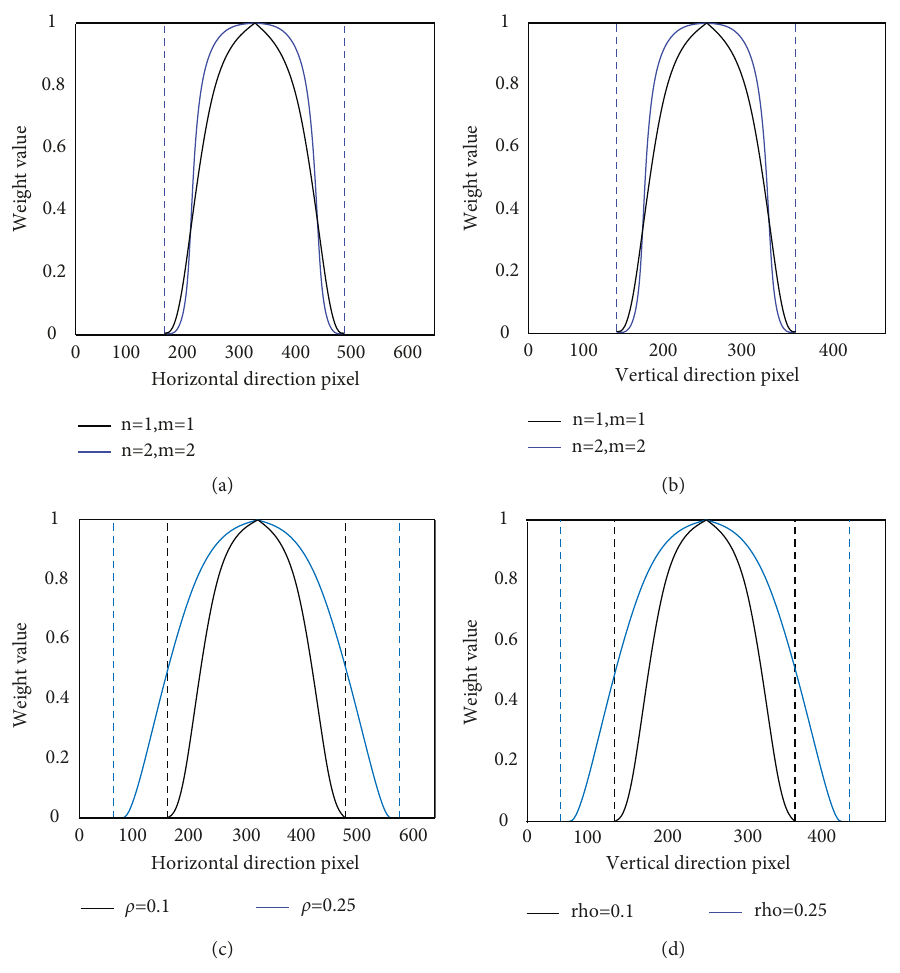
Figure 2: Curve diagrams of feature weights. (a) Horizontal direction weight curve diagram, n/m. (b) Vertical directional weight curve diagram, n/m. (c) Horizontal direction weight curve diagram, ρ . (d) Vertical directional weight curve diagram, ρ